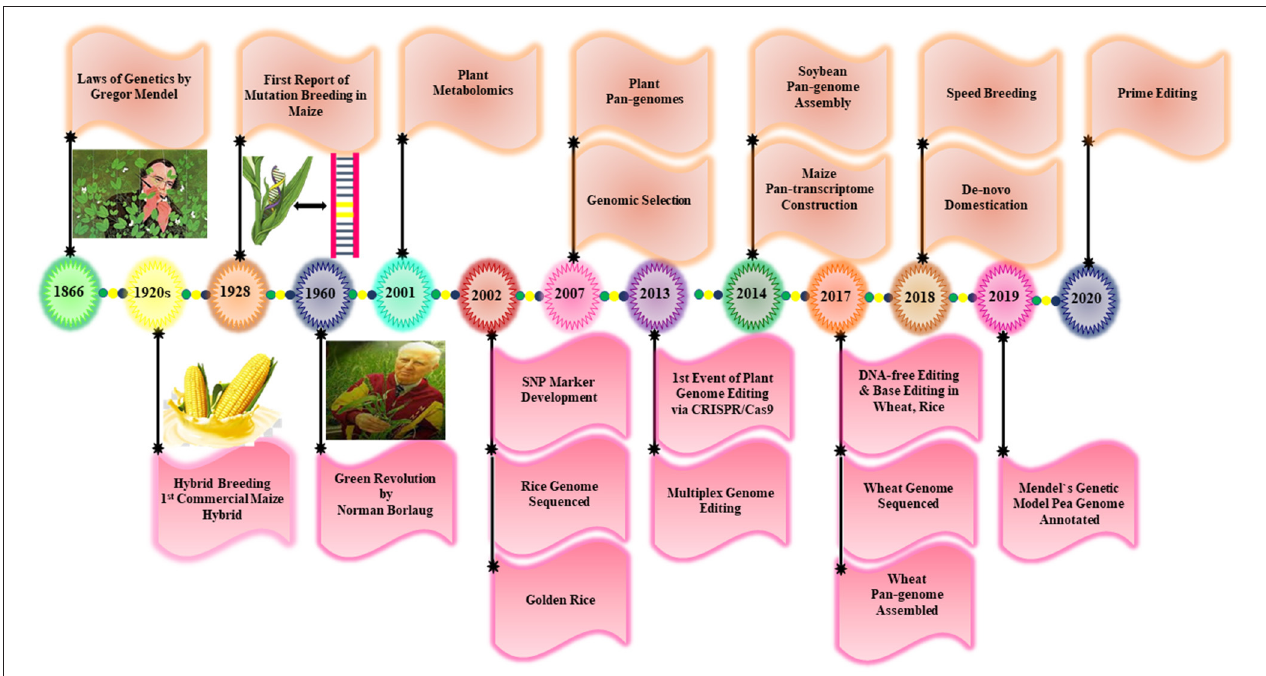
FIGURE 3 | Representations of the key milestones achieved by conventional and modern plant